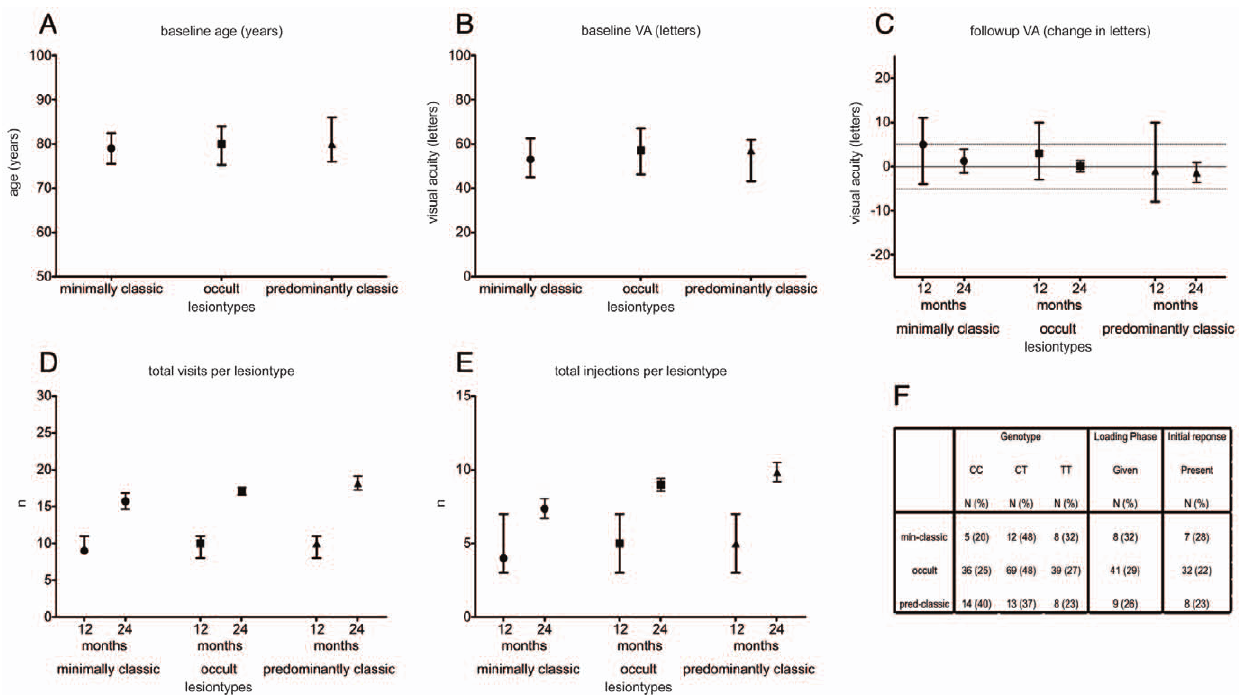
Figure 1. Overview of three different lesion-types. Values are displayed for age at baseline (A), visual acuity at baseline (B), VA at 12 and 24 months (C), number of visits in 12 and 24 months (D), total injections in 12 and 24 months (E) and the distribution of genotypes (F). Symbols show the median while whiskers indicate the interquartile range. No statistically significant differences are found.